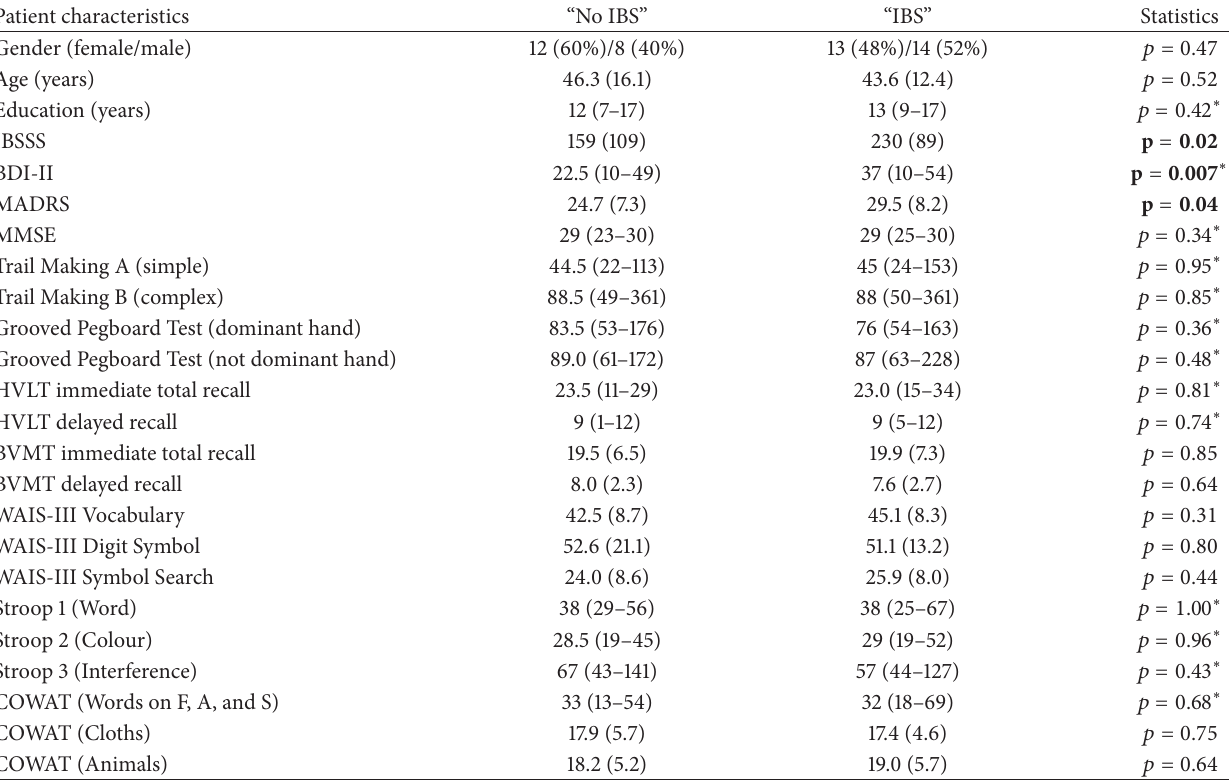
Table 3: Patient characteristics and comparisons of patients with and without IBS in the “Depression”